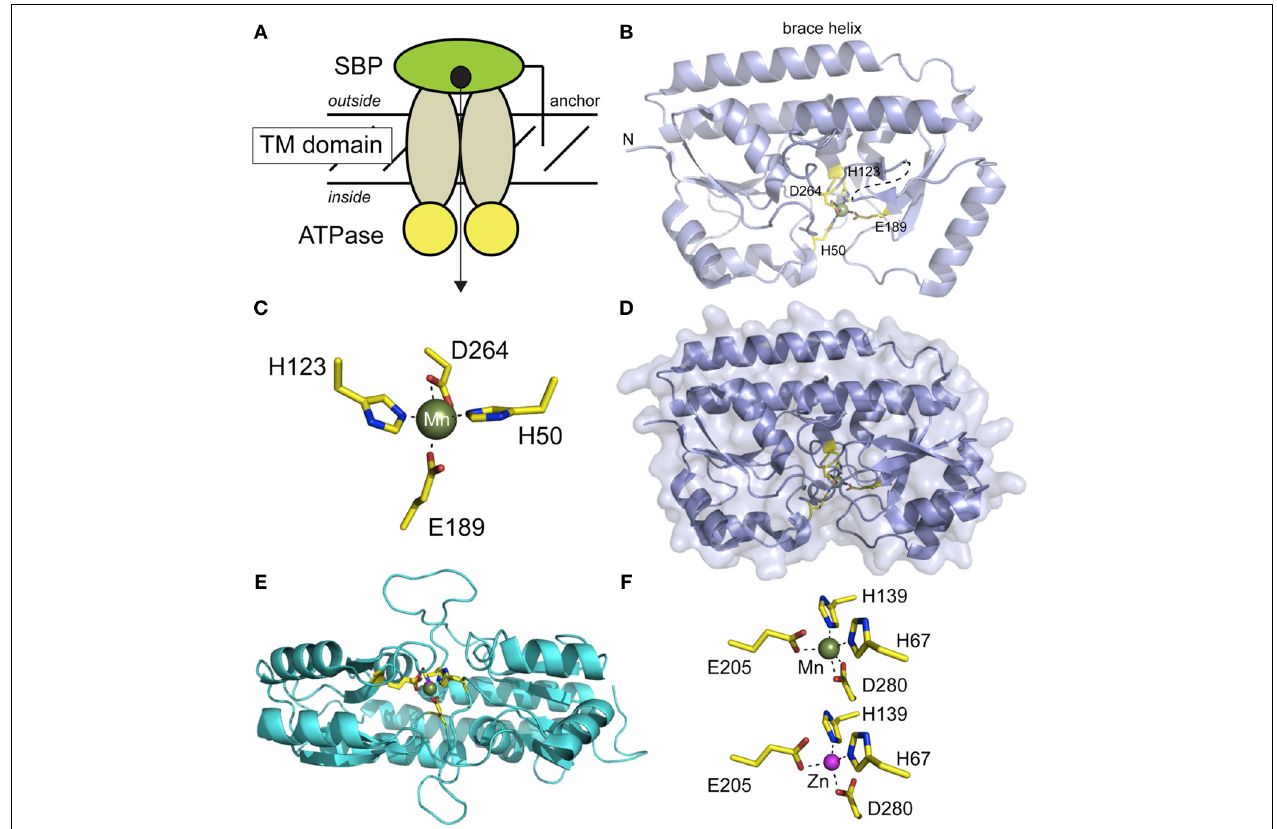
FIGURE 4 | Structural studies of Mn-specific solute binding proteins (SBPs) from S. aureus MntC (panels B-D) (Gribenko et al., 2013) and S. pneumoniae PsaA (panels E,F) (Lawrence et al., 1998; McDevitt et al., 2011). (A) Cartoon representation of a canonical ABC transporter, with the subunits and the direction of transport labeled. (B) Ribbon representation of the structure of Mn-bound MntC (pdb code 4K3V), with the four Mn(II)-coordinating ligands highlighted and shown in stick . This orientation is similar to that implied by the cartoon in panel (A) . (C) First coordination sphere of the Mn(II) complex in MntC; this orientation differs from that in panel B in order to highlight the distorted trigonal bipyramidal Mn(II) coordination geometry. E189 tends toward monodentate ligation, while D264 is bidentate. (D) Surface representation of MntC in the same orientation as in